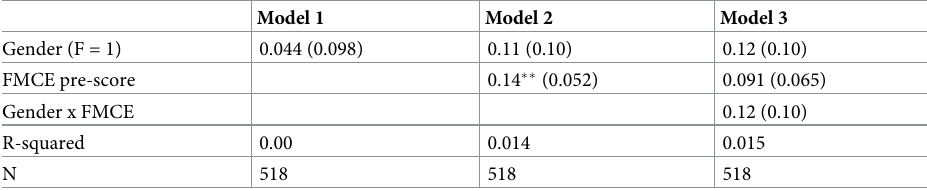
All coefficients are standardized to be in units of standard